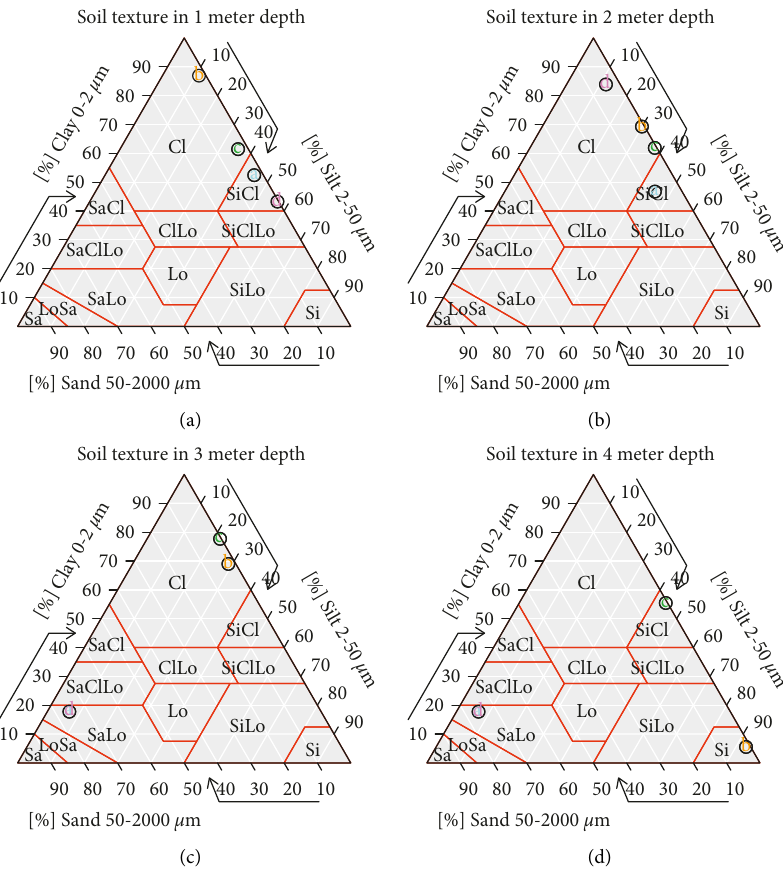
Figure 3: USDA triangle soil texture in 1 st to 4 th meters depth in the landform of Barito Delta. Soil texture in each landform indicates with color alphabet, that is, (a) with light blue color, Tidal Flat (Sample No. 29); (b) with orange color, Natural Levee (Sample No. 1); (c) with green color, Limb of Peat Anticline (Sample No. 44); and (d) with violet color, Basin of Peat Anticline (Sample No.